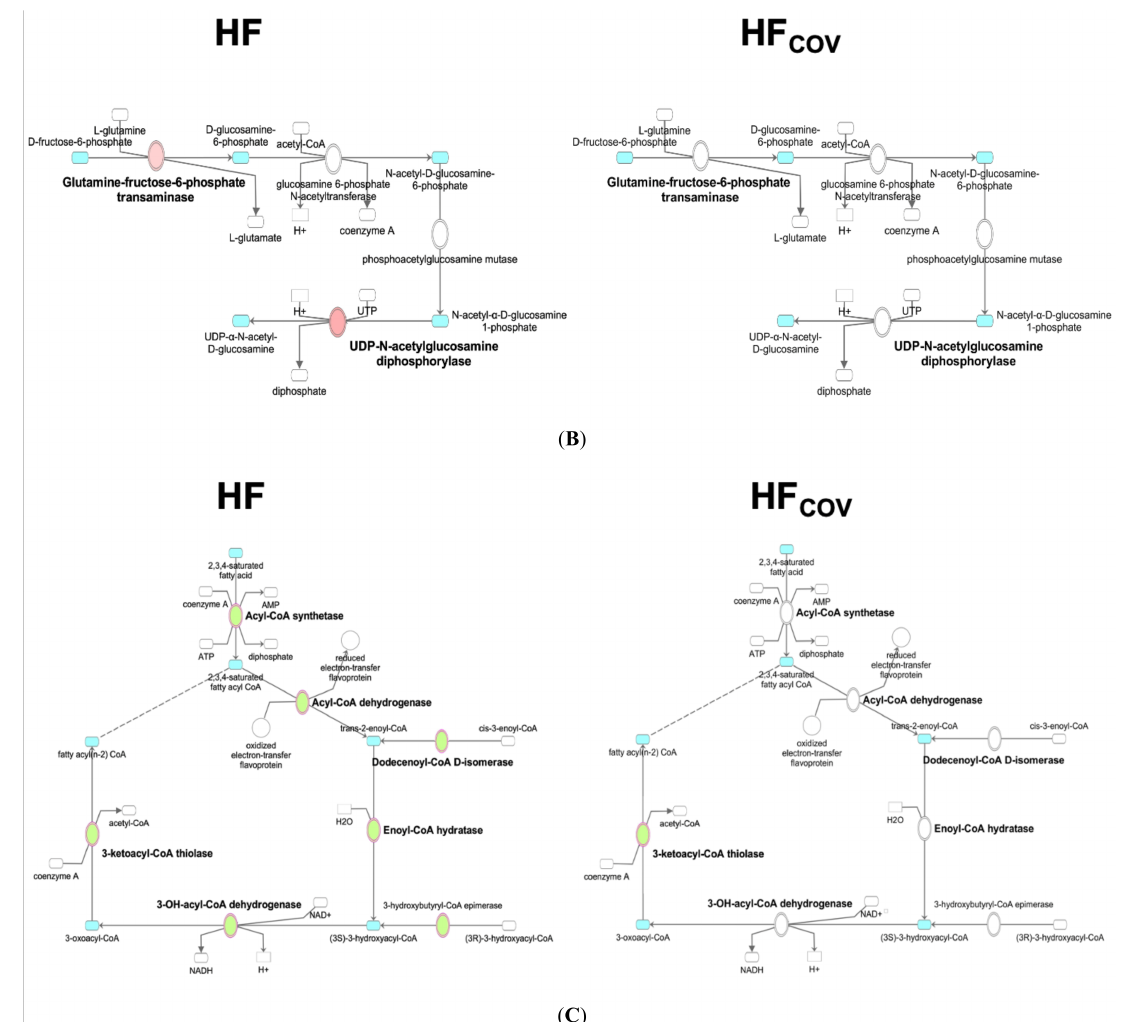
Figure 3. Differential expression of genes (fold change > 1.5 and p < 0.05) involved in glycolysis ( A ), hexosamine biosynthetic pathway ( B ), and fatty acid oxidation ( C ) in volume-overloaded rats in the heart failure (HF) phase and in volume-overloaded rats after correction of volume overload in the HF phase (HF COV ). The ovals in the maps represent enzymes in each metabolic pathway, with red and green denoting upregulation and downregulation of gene expression, respectively. n = 4 per